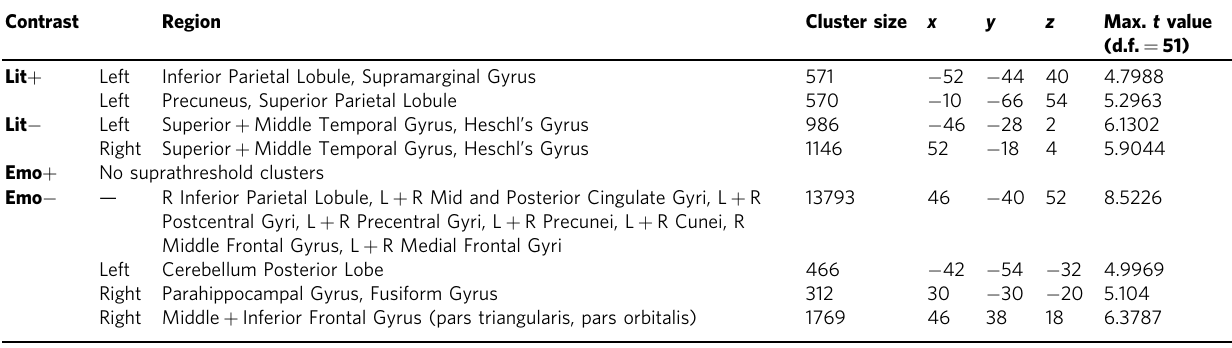
Table 1 fMRI results of whole-brain analysis for literariness and emotional